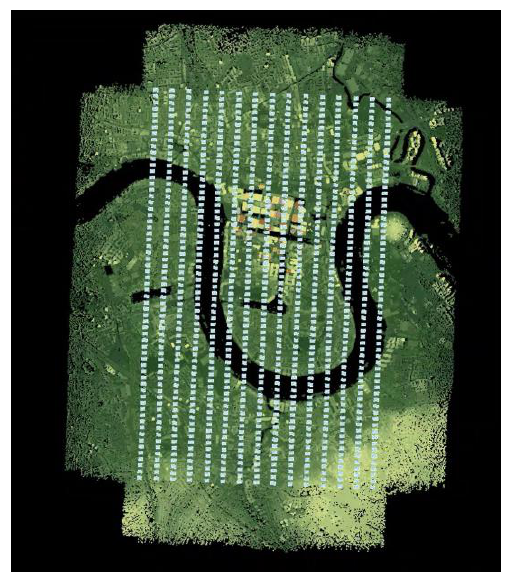
Figure 10 : UltraCam Osprey 4.1 large scale mission in